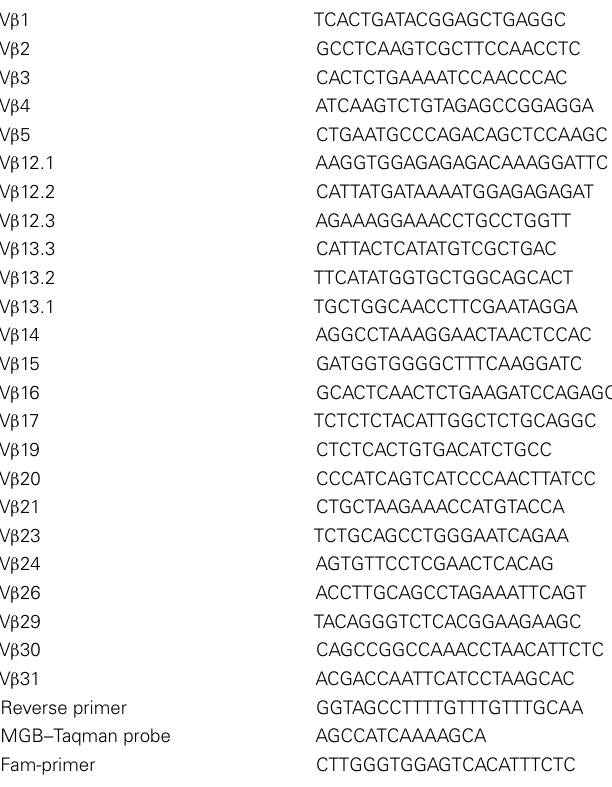
TableA2 | Sequences of the primers used for the immunoscope analysis.